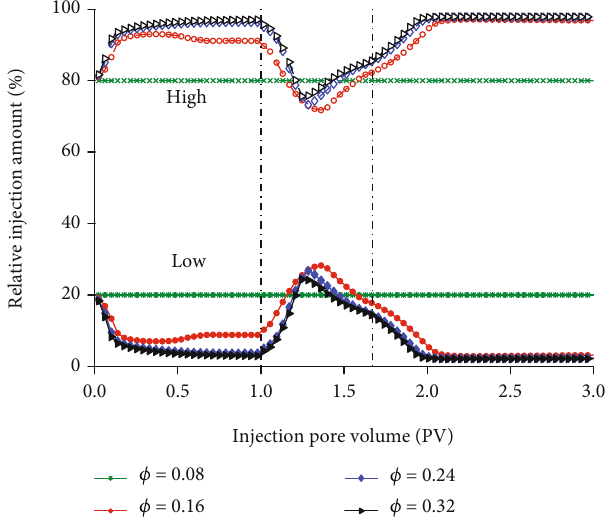
Figure 8: Injection conformance behavior for reservoirs with di ff erent porosity ratios of low to high permeable zones.